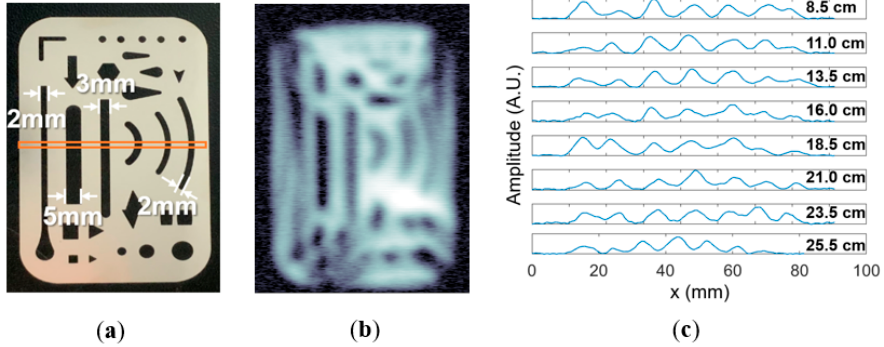
Figure 10. Imaging results using the proposed imaging scanner system. ( a ) Photograph of the metal erasing shield. ( b ) Imaging results of the complete metal erasing shield at the objective distance of 13.5 cm. ( c ) Imaging results of a partial metal erasing shield at different object distances.